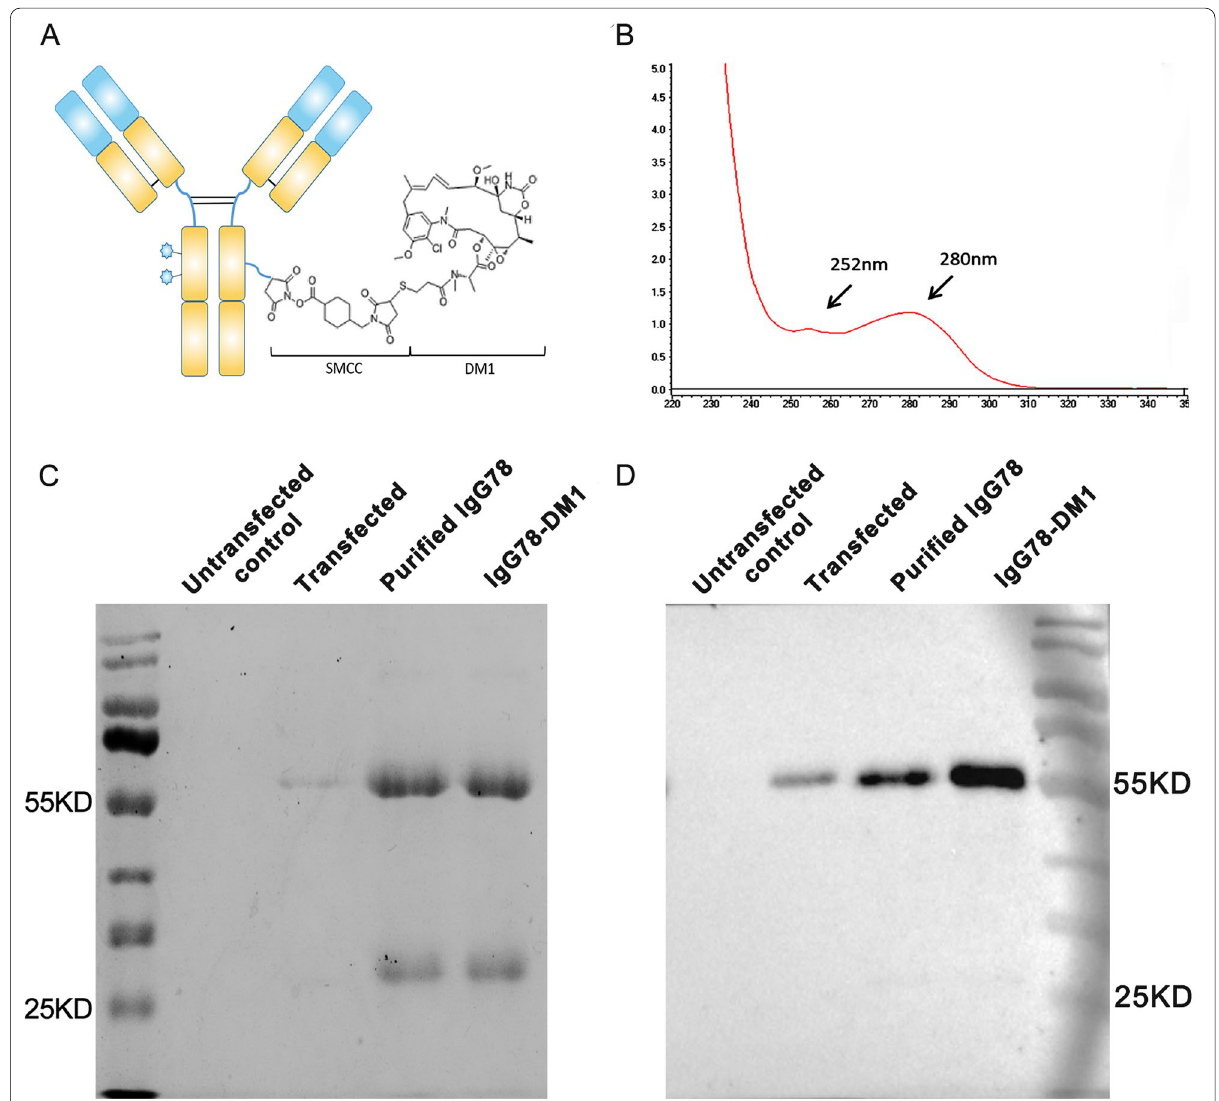
Fig. 3 Purification of IgG78 and preparation of IgG78‑DM1. A Schematic diagram of IgG78‑DM1. B Characterization of IgG78‑DM1 using a Nanodrop spectrophotometer to show the absorption peak of DM1 and IgG78 at 252 nm and 280 nm, respectively. C SDS‑PAGE showing the expression of purified IgG78 and IgG78‑DM1. D Western blotting to showing the purified IgG78 and generated IgG78‑DM1. DM1 Mertansine, SDS-PAGE sodium dodecyl sulfate polyacrylamide gel